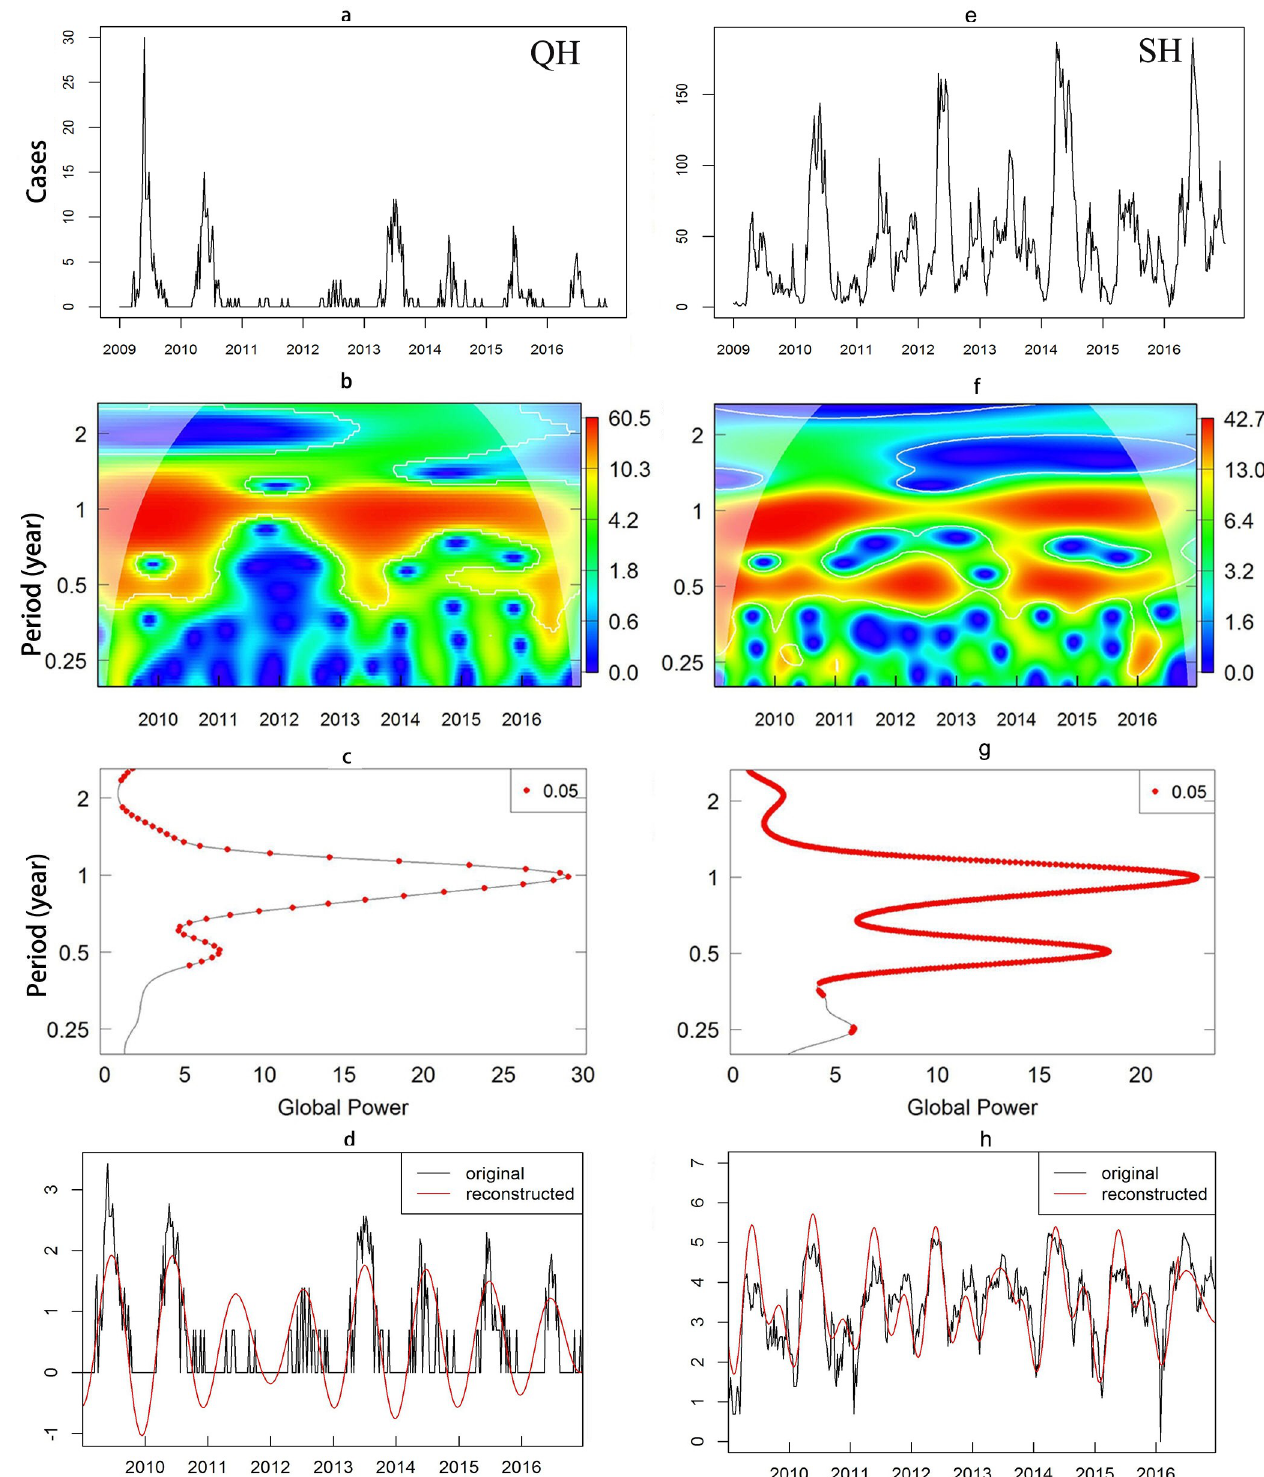
Fig 2. Temporal pattern and periodicity of HFMD. a/e . Weekly pattern of HFMD in Huangzhong (Qinghai) and Fengxian (Shanghai). b/f , Local wavelet power spectrum in Huangzhong and Fengxian. c/g , Global wavelet spectrum (red points represent periods with 95% statistical significance) in Huangzhong and Fengxian. d/h , Major epidemic component of the incidence series in Huangzhong (mainly annual) and Fengxian (mainly annual and semi-annual), reconstructed with wavelet spectral analysis from the components in their respective period. All the plots were created using R software (R Development Core Team